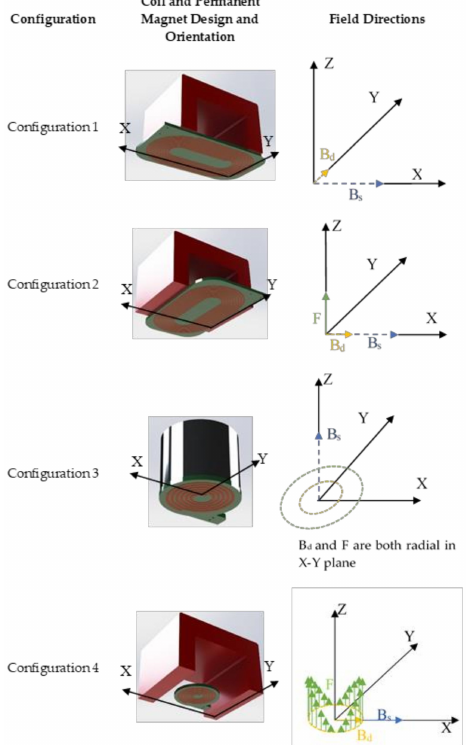
Figure 5. Illustration of the di ff erent EMATs for di ff erent configuration and the directions of bias field, dynamic field and Lorentz forces if